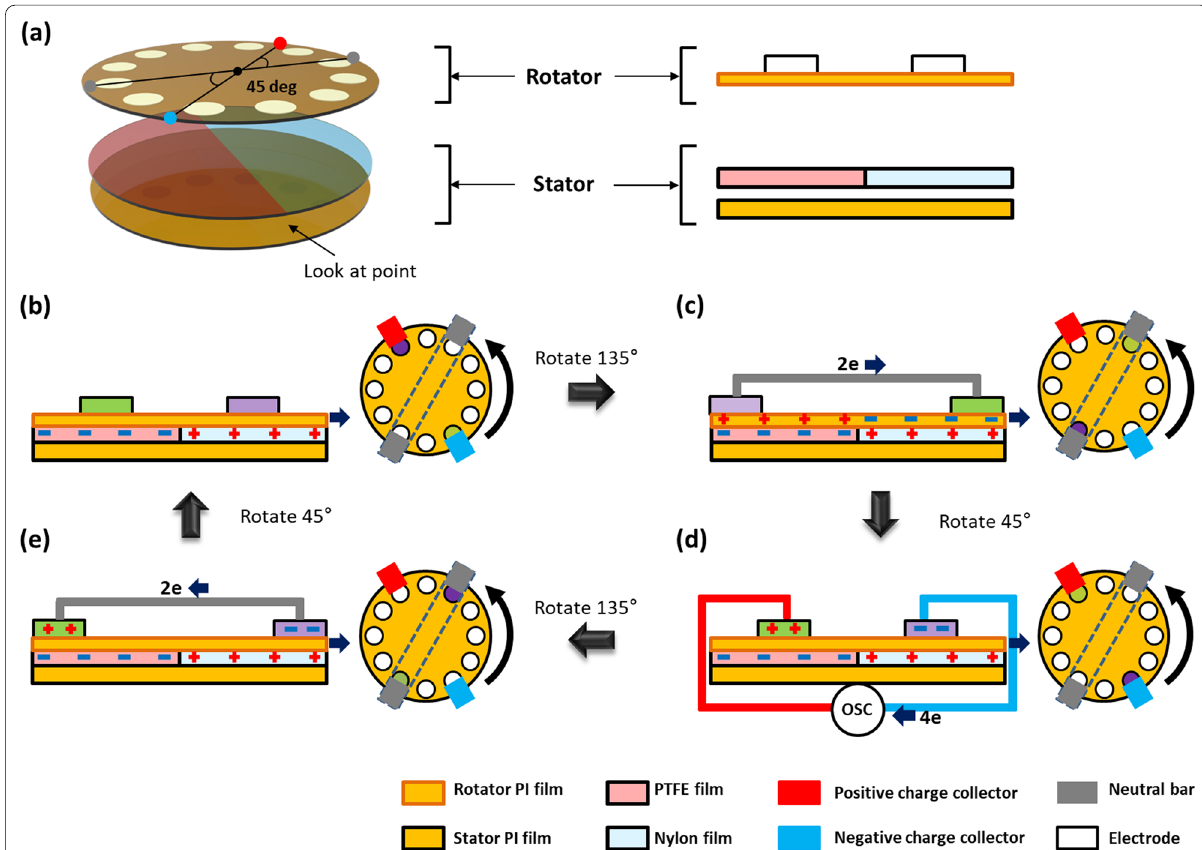
Fig. 2 The working mechanism of the TENG. a Schematic description of the film‑type TENG. b – e Schematic illustration showing the suggested working mechanism of the film‑type TENG with electron flow